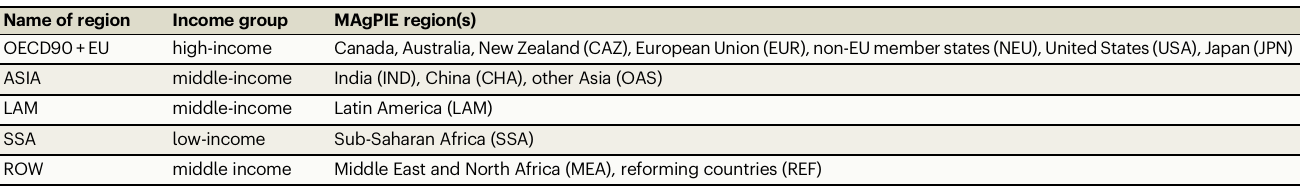
Table 2 | Regional mapping Name of region